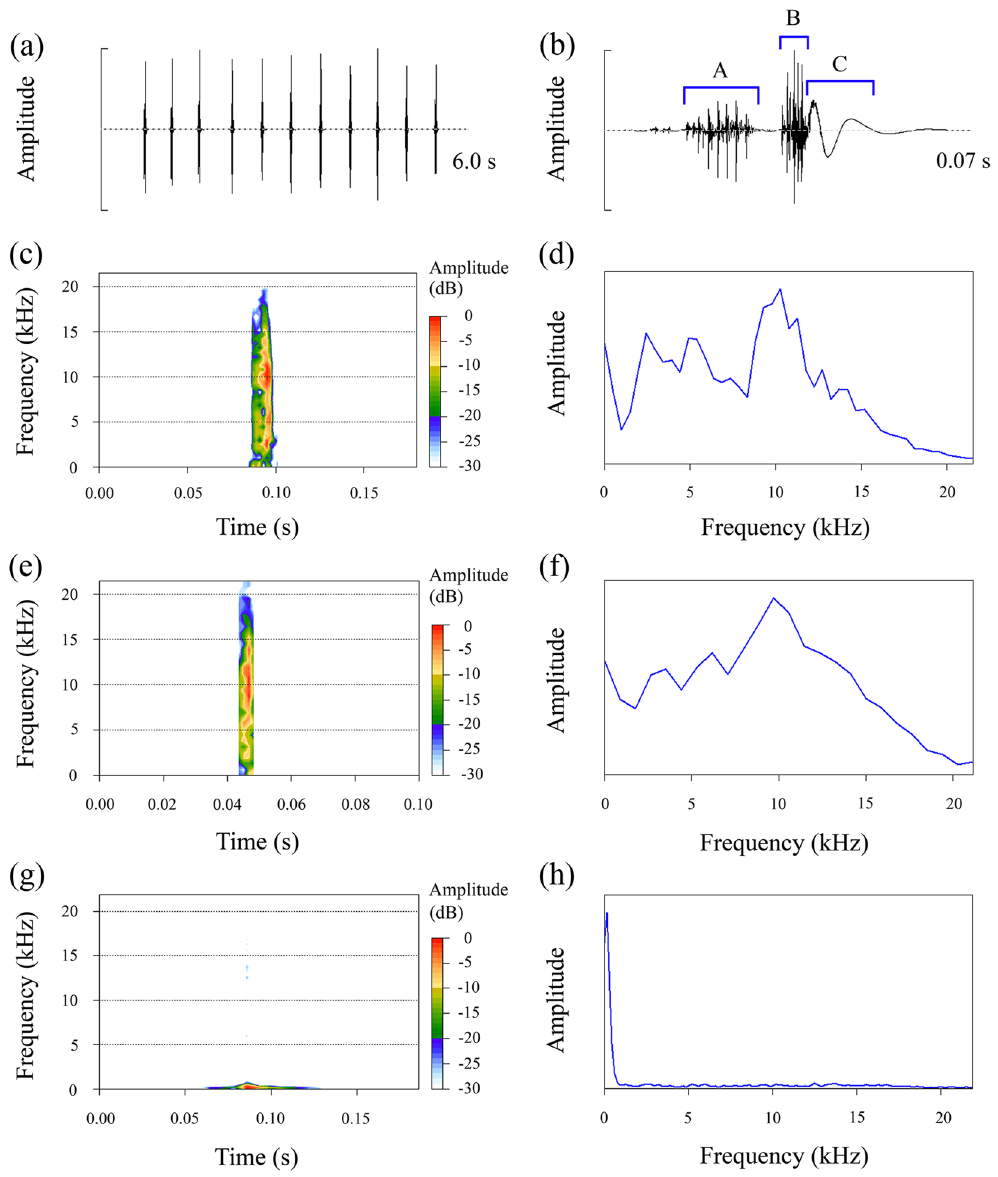
Figure 2. Analysis of sounds produced by female S . yangi . ( a ) Oscillogram of 11 sounds produced by a female. ( b ) Detailed oscillogram of a single sound. ( c , d ) Spectrogram (time vs frequency vs amplitude, colour amplitude scale given on the right) and mean spectrum (frequency vs amplitude) of the component A. ( e , f ) Spectrogram and mean spectrum of the component B. ( g , h ) Spectrogram and mean spectrum of the component